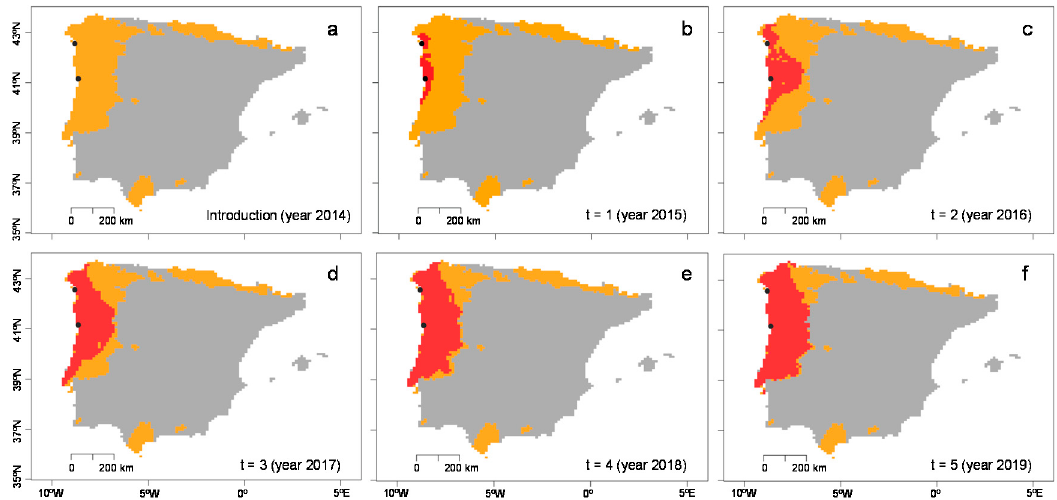
Figure 5. Evolution of the predicted area invaded by Trioza erytreae since its introduction in the Iberian Peninsula ( a ) using the kernel model with two entry points at Vilanova de Arousa (Spain) and Porto (Portugal) after one ( b ), two ( c ), three ( d ), four ( e ), and five years of simulation ( f ). Orange areas represent favorable habitat suitability. Red areas represent invaded areas. Black dots represent entry points. Results are shown for mainland Portugal and Spain and the Balearic islands.